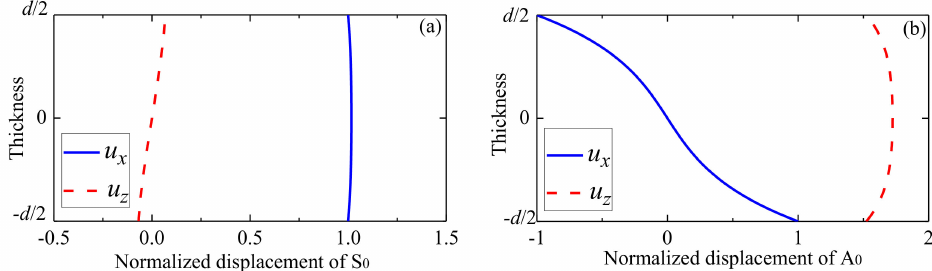
Figure 2. Normalized displacement components of Lamb waves in the plate of thickness d : ( a ) the S 0 mode; ( b ) the A 0 mode.